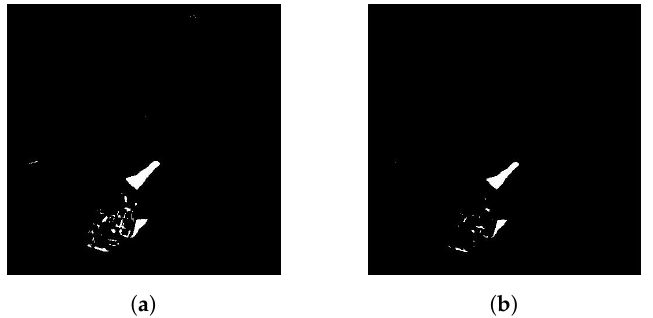
Figure 19. Example of adjustment of objects found in the binary image by erosion filtering. Erosion filtering of objects by 3 pixels. ( a ) The original binary image of the findings after binarization of the difference finding. ( b ) Image ( a ) filtered by noise objects using erosion.